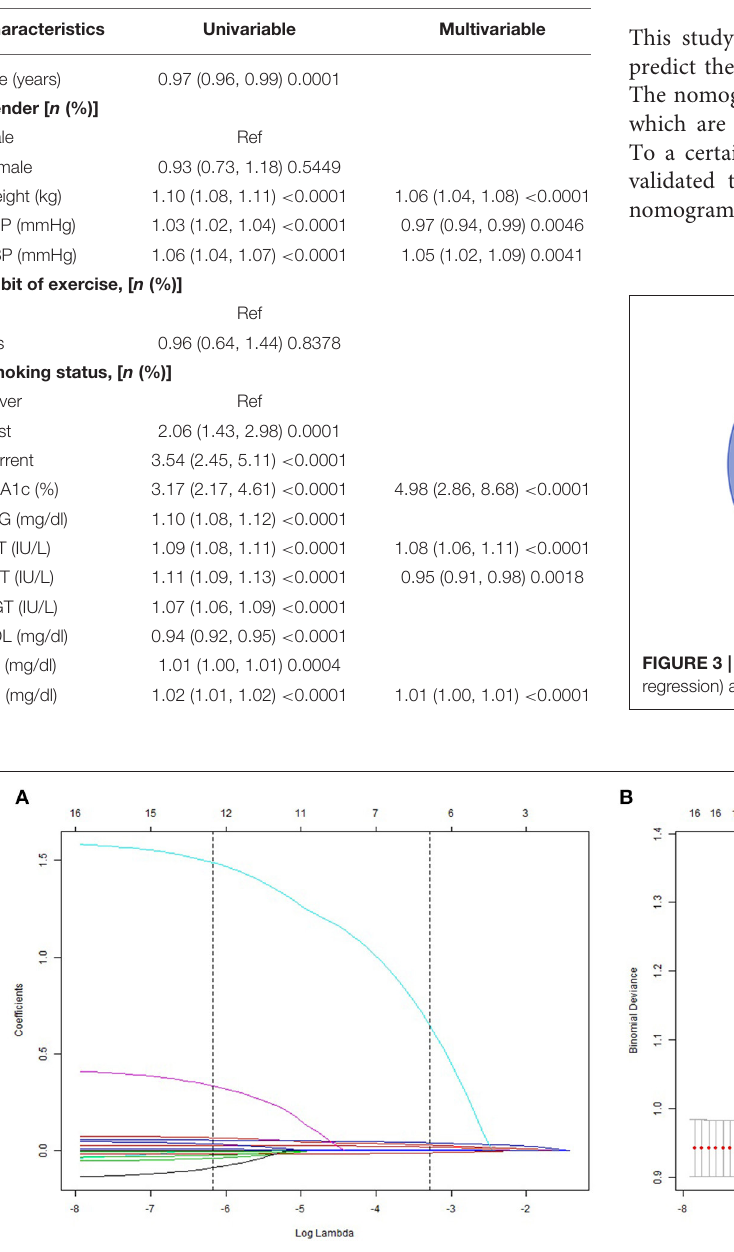
Frontiers in Public Health |